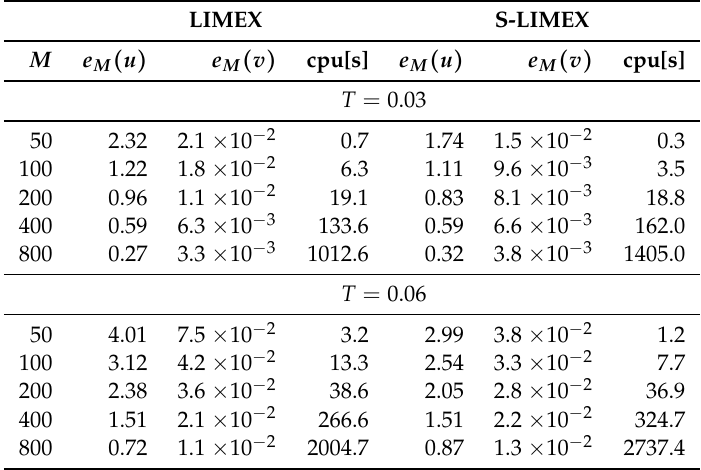
Figure 3. Example 1: 1-D projection of the numerical solution onto the line y = x : ( left ) evolution of the non-dimensional temperature during short time intervals, ( right ) comparison of the numerical approximations (with M = 200 and M = 400 at time T = 0.16) obtained by LIMEX and S-LIMEX schemes with the reference solution. Table 1. Example 1: Approximate L 1 errors e M ( u ) , e M ( v ) and CPU time.